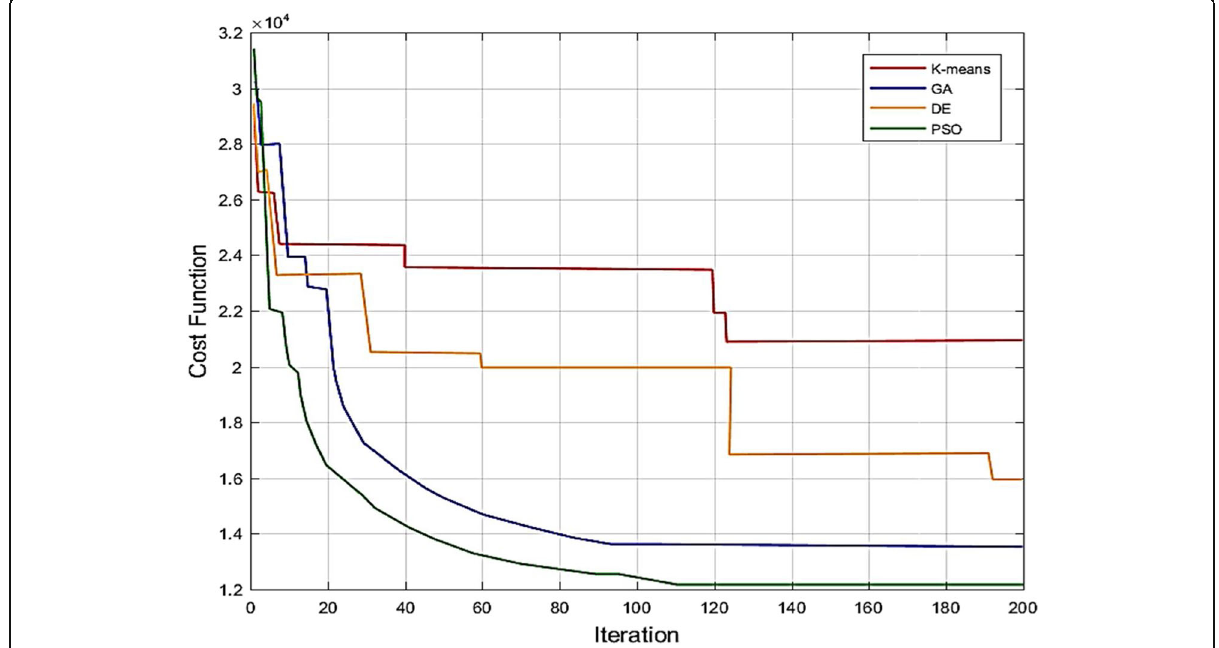
Fig. 1 Comparison graph of four proposed algorithms using DB and CS